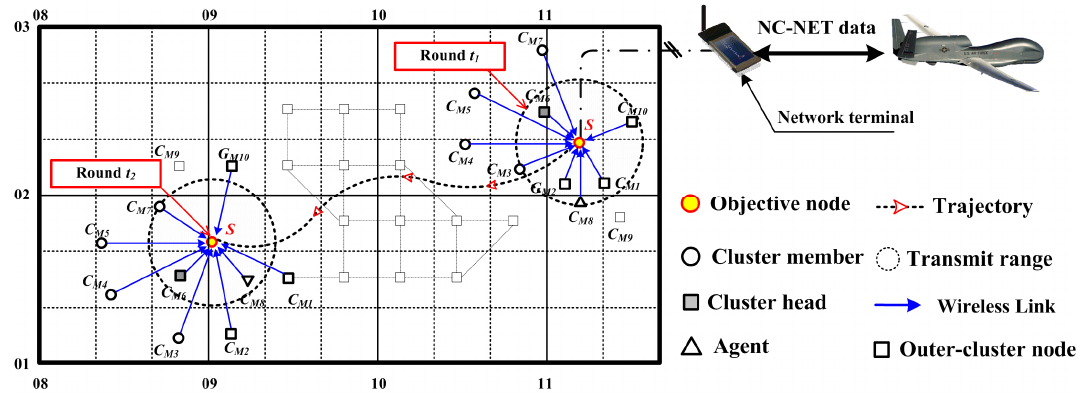
Figure 1. Typical illustration of networked UAVs based on NC-NET.